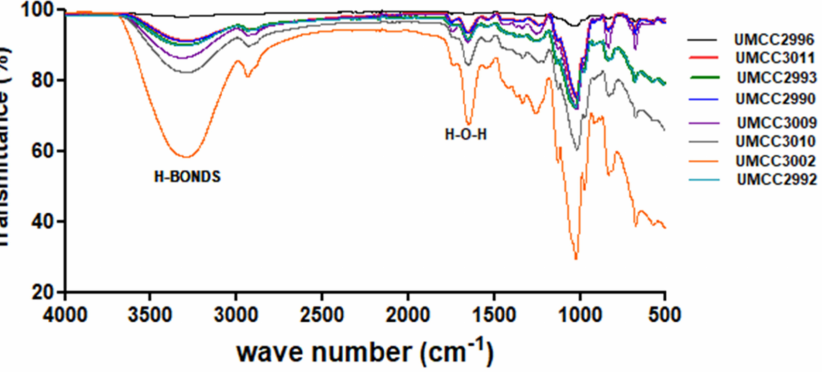
Figure 4. ATR-FTIR spectra of the freeze-dried samples obtained from the tested lactic acid bacte- ria